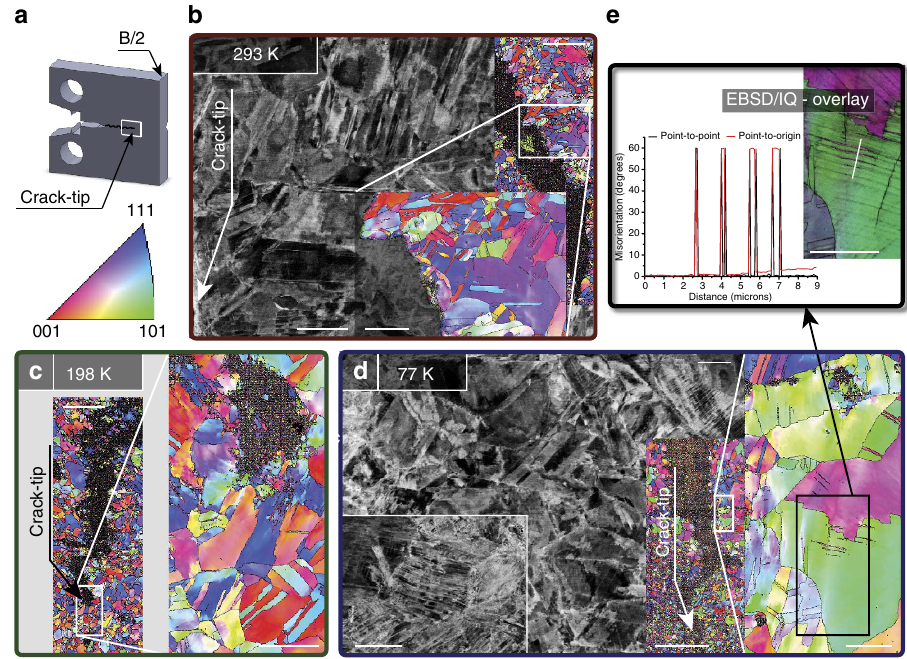
Figure 3 | Deformation mechanisms in CrCoNi between 293 and 77K. ( a ) After testing, some samples were sliced in two along the half-thickness mid-plane, and the crack-tip regions in the centre of the samples (plane strain) were investigated in the scanning electron microscope using back-scattered electrons (BSE) and electron-backscatter diffraction (EBSD). ( b ) EBSD scans in the wake of the propagated crack of a sample tested at room temperature show a few recrystallization twins and grain misorientations indicative of dislocation plasticity whereas BSE scans reveal cell formation and nano-twinning as additional deformation mechanism. ( c ) Similar to room temperature behaviour, EBSD scans of samples tested at 198K show recrystallization twins and misorientations indicative of dislocation plasticity ahead of the propagated crack-tip. ( d ) Samples tested at 77K show pronounced nano-twinning and the formation of dislocation cells (BSE), whereas EBSD scans reveal dislocation plasticity in the form of grain misorientations, some recrystallization twins and deformation induced nano-twins. ( e ) An arbitrarily chosen path on an EBSD image overlaid on an image quality (IQ) map shows 60 (cid:2) misorientations typical for the character of such deformation twins. (The IQ map measures the quality of the collected EBSD patterns and is often used to visualize microstructural features.) The scale bars of the BSE image, the EBSD image and the inset of the EBSD image in b are 5, 75 and 25 m m, respectively; the ones of the EBSD image and its inset in c are 50 and 10 m m, respectively. The BSE image and its corresponding inset, and the EBSD image and its inset have scale bars of 10, 5, 200 and 15 m m, respectively. The scale bar in e is 15 m